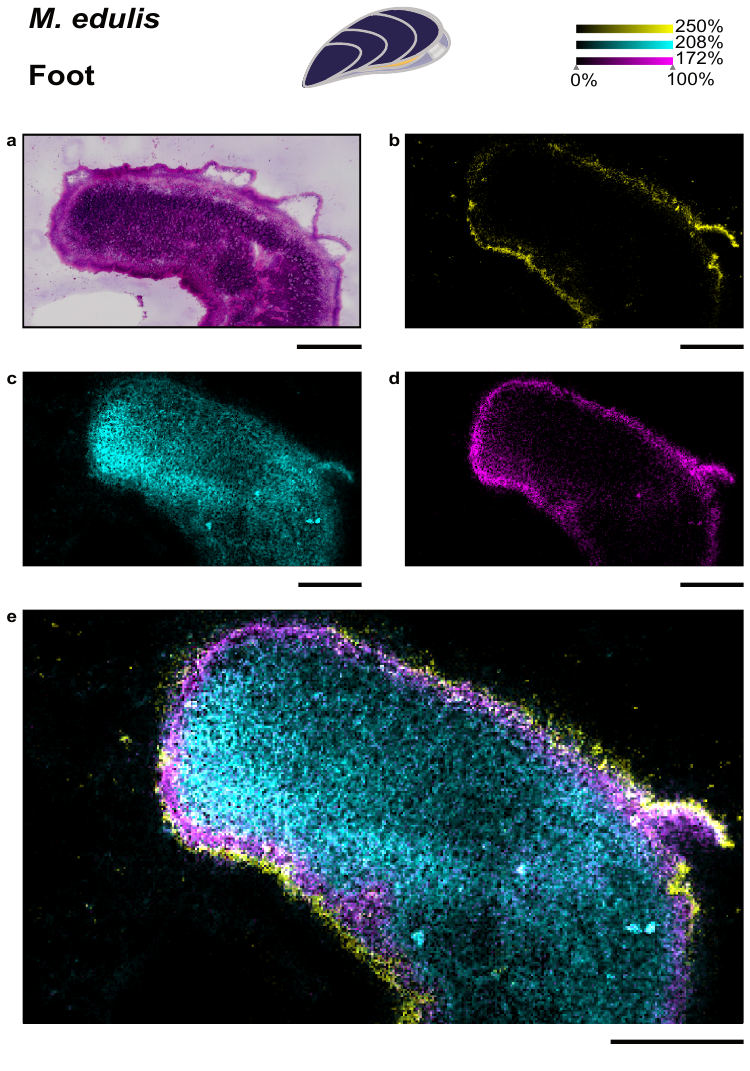
Figure 4 Specific lipid distributions in M. edulis foot. (A) histology of M. edulis foot tissues stained with H&E, ion-maps showing the distribution of (B) epithelia-specific phosphonolipid (PnE-Cer(34:1) m/z 667.5155 [M+Na] + ) in yellow, (C) ubiquitous phospholipid (PS-(35:0) m/z 802.5359 [M+K] + ) in cyan (D) colocalized phospholipid (PC(36:4)/PS(O-38:4), m/z 820.5463 [M+Na] + ) in magenta, co-localization value = 0.41, highest colocaliztation value to epithelia-specific PnE-Cer(34:1), (E) overlay of all three lipids shown in (B), (C), (D). Scale bars: 500 µ m. Full-size DOI: